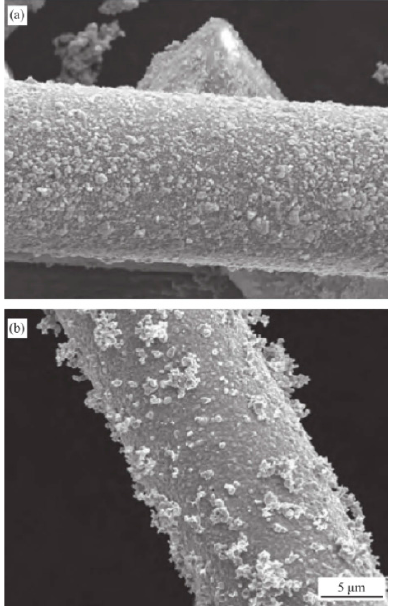
Figure 1. SEM image of GF. (( a ) magnification is 10 μ m, ( b ) magnification is 5 μ